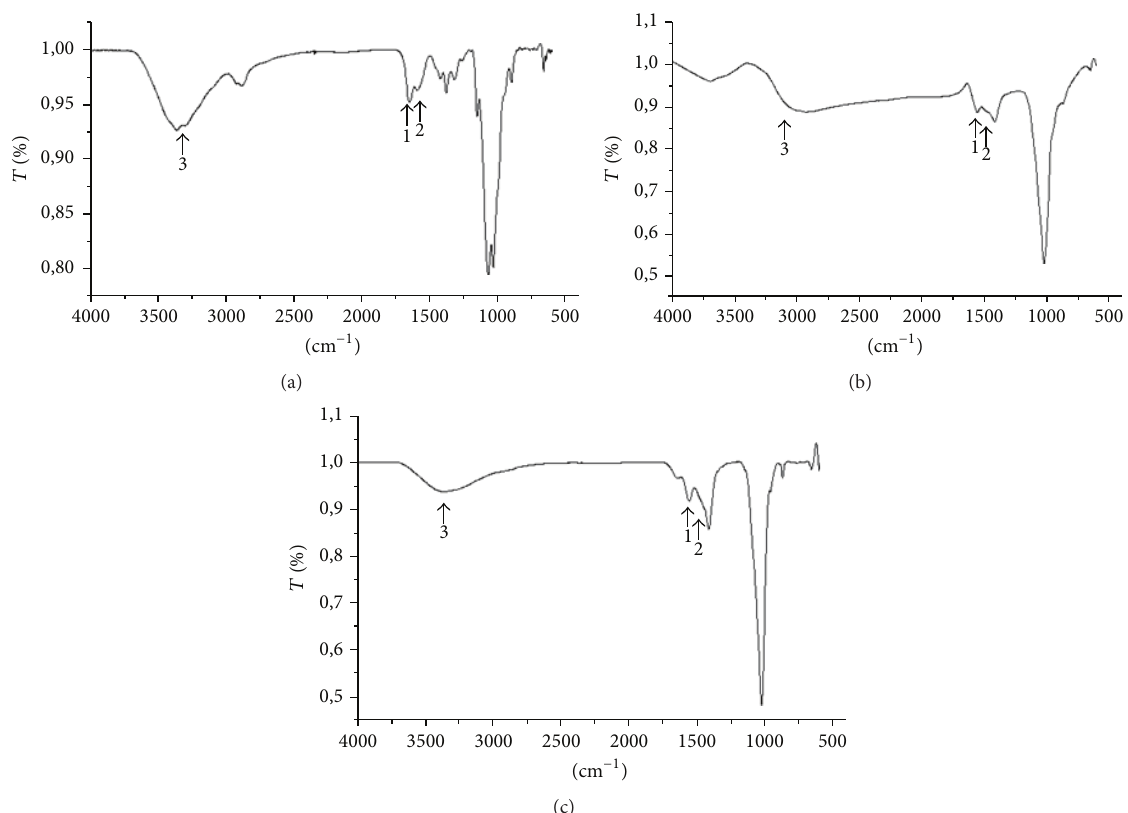
Figure 1: Infrared absorption spectra: (a) commercial chitosan (Sigma Aldrich Corp., St. Louis, MO, USA); (b) chitosan obtained by Method 1 [17]; (c) chitosan obtained by Method 2 [18]. The peaks in chitosan were indicated as 1 = ( ∼ 1650 cm −1 ) acetylated residues (NHCOCH 3 ); 2 = ( ∼ 1590 cm −1 ) NH 2 groups present in the deacetylate residues; and 3 = (3440 cm −1 ) the vibration of the OH